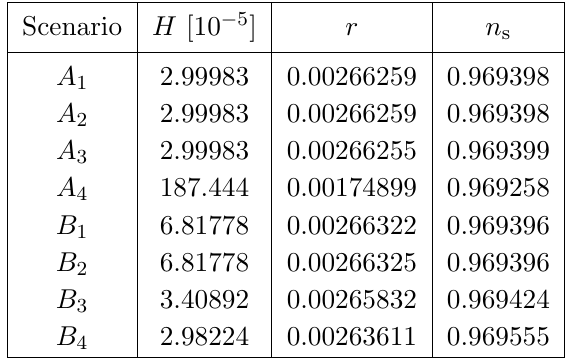
Table 4. The Hubble parameter H (in units of M Pl ), tensor-to-scalar ratio r and spectral index n s for successful in(cid:13)ationary scenarios at N (cid:3)